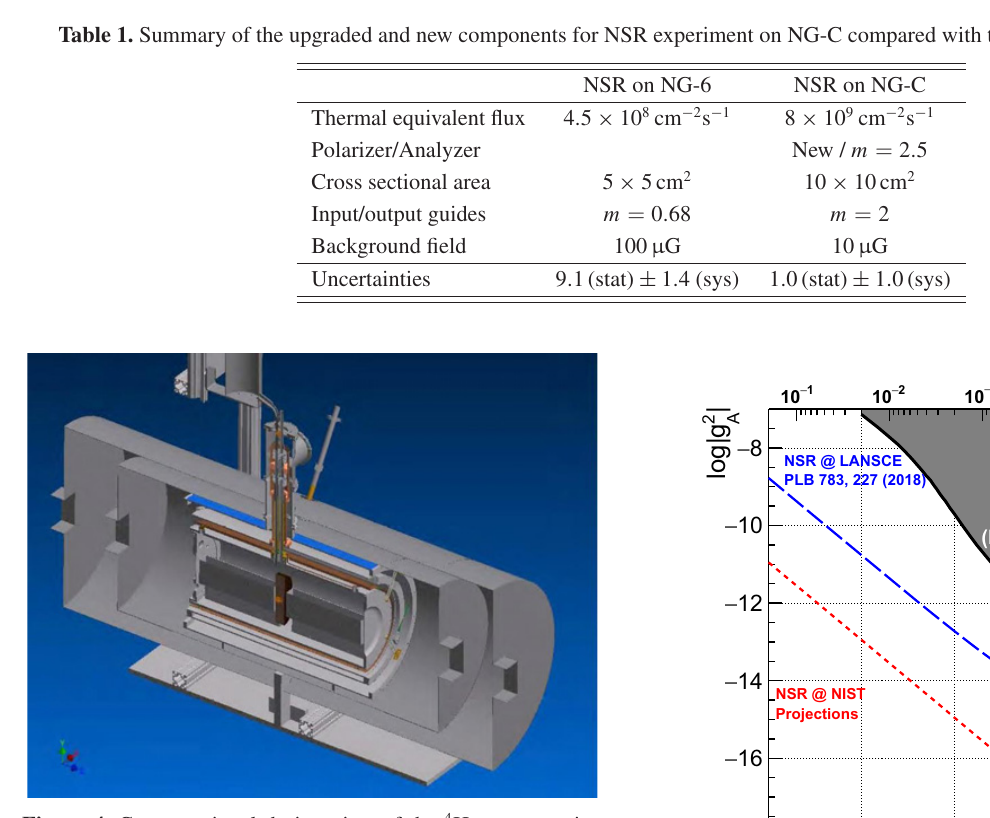
Figure 4. Cross sectional design view of the 4 He target region with a port through the top to the He liquefier.